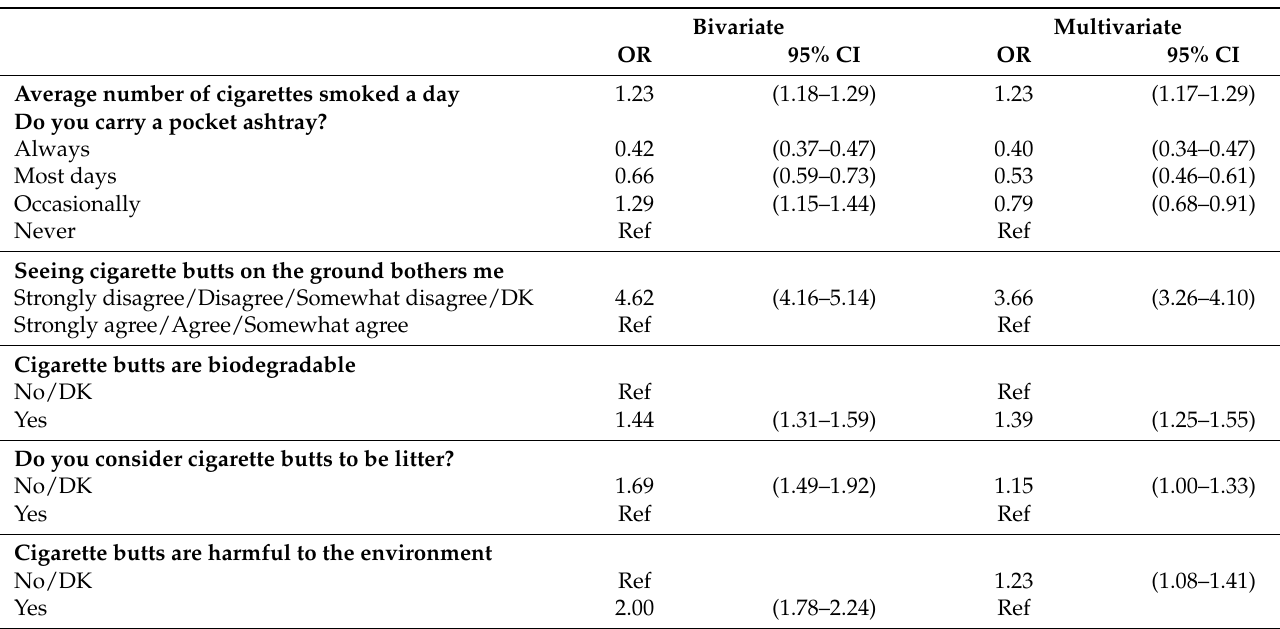
Table 4. Statistically significant predictors of past-month cigarette-butt littering † among college-age smokers ( n = 7532, p <